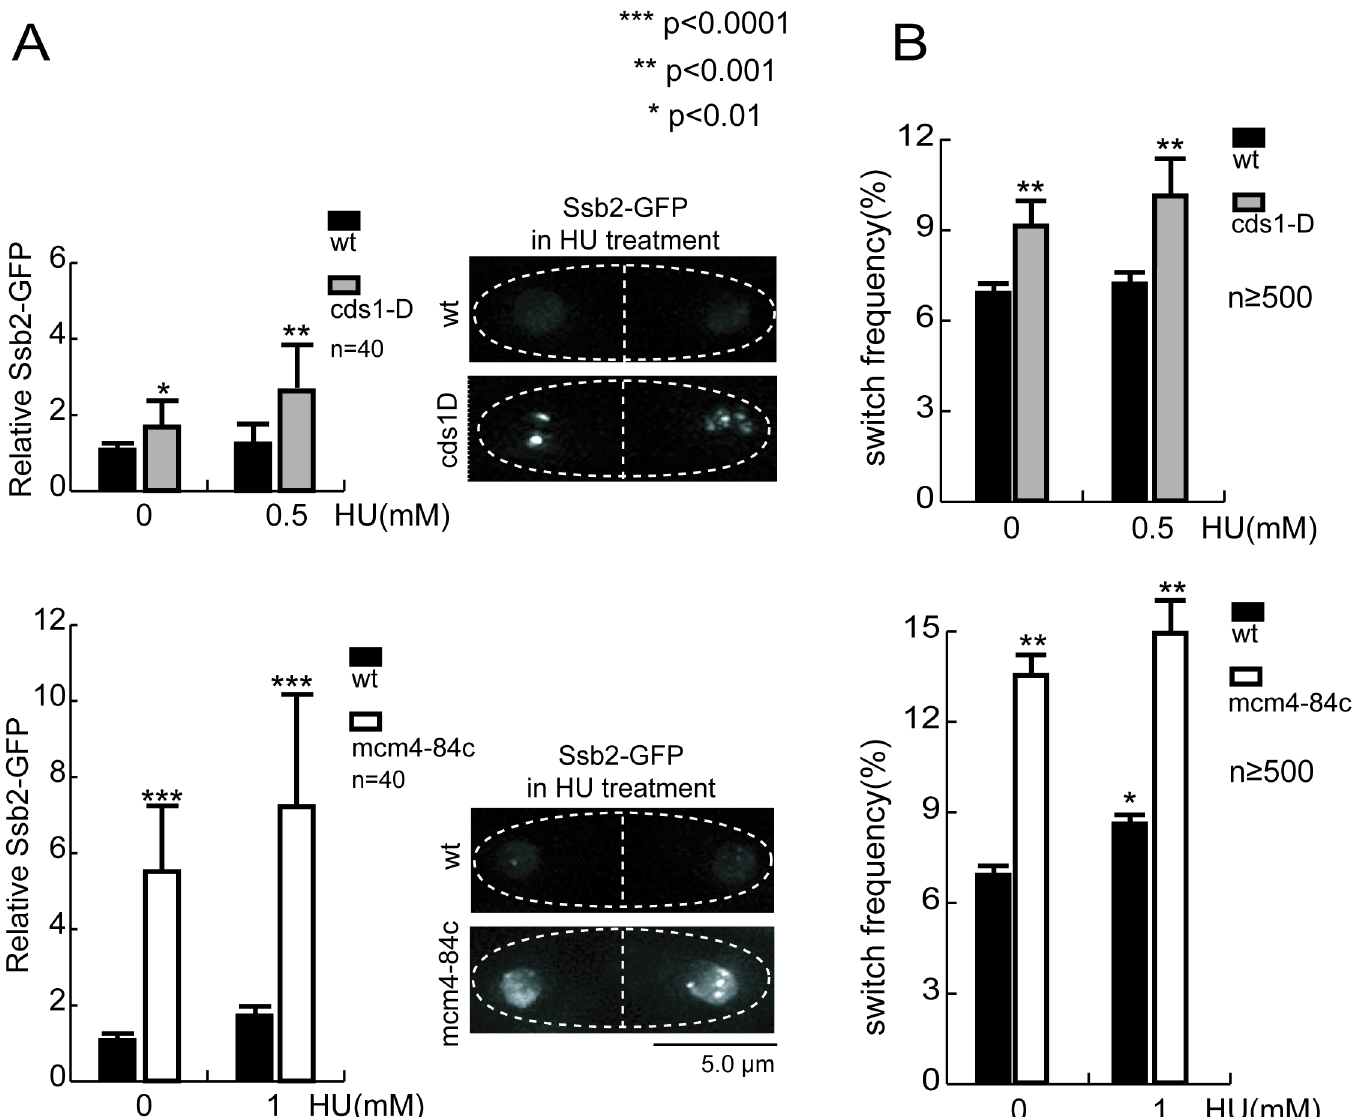
Fig 2. Enhanced centromeric PEV correlateswith excessive formation of ssDNAupon HU treatment. (A) Quantificationof Ssb2-GFP foci signalin S- phase cells. Cells are treated with HU as labeledfor 6 hours, the Ssb2-GFP signal is quantified microscopically in live S phase cells (with a septum). Representative cell treated with HU images are shown on right. Ssb2-GFP signal in each nucleusequalsthe sum of all the foci within the nucleus.Forty nuclei are measuredeach and the average ± SD are shown, normalized with the value of wild type cells with no HU (1X). p values are calculatedby t test. (B) Elevated frequencies of cnt2 :: ade6 + red-to-white switchingmeasuredby pedigreeanalysisin cds1-D and mcm4-84c mutants. Switchingrate is measuredas in Fig 1C. For each experimental condition(specific genotypeplus HU concentration), colony color switchingevents are scored in 500–600cell division events in total. The error bars are 1 SD of percentages for four independent